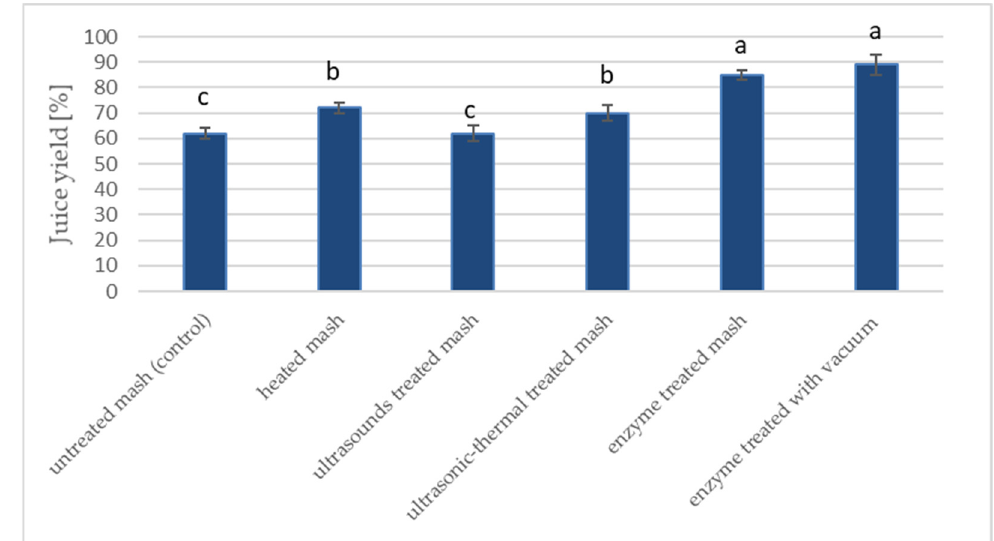
Figure 1. Effect of mash treatment on juice yield (values are means ± standard deviation; the different letters (a–c) indicate a significant difference at p < 0.05 for analysis of variance (ANOVA) and post-hoc analysis performed with Tukey’s test).